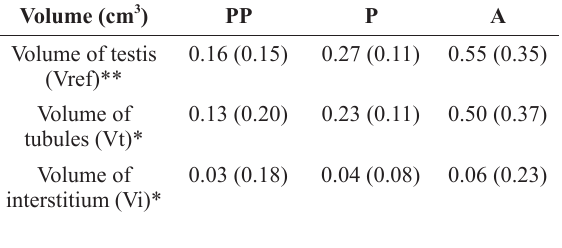
The mean values of the total volume of the testis (Vref), seminiferous tubules (Vt) and interstitium (Vi) in cutia.